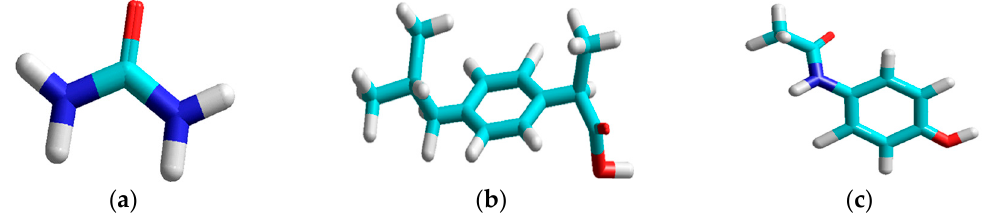
Figure 2. Chemical structures of ( a ) urea; ( b ) ibuprofen; and ( c ) acetaminophen. Oxygen is highlighted in red, nitrogen in dark blue, carbon in light blue, and hydrogen in white.